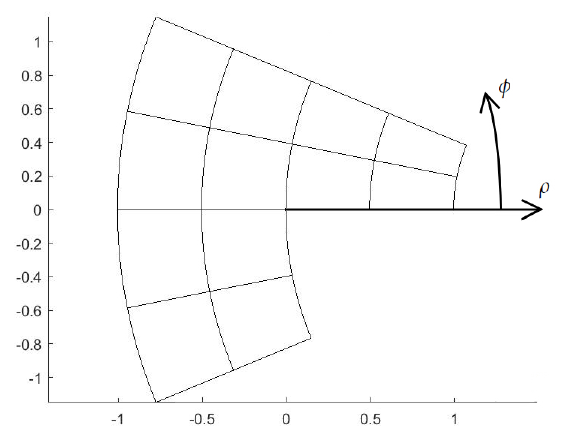
Figure 8. Curved L-shaped domain with the initial mesh mapped on it.